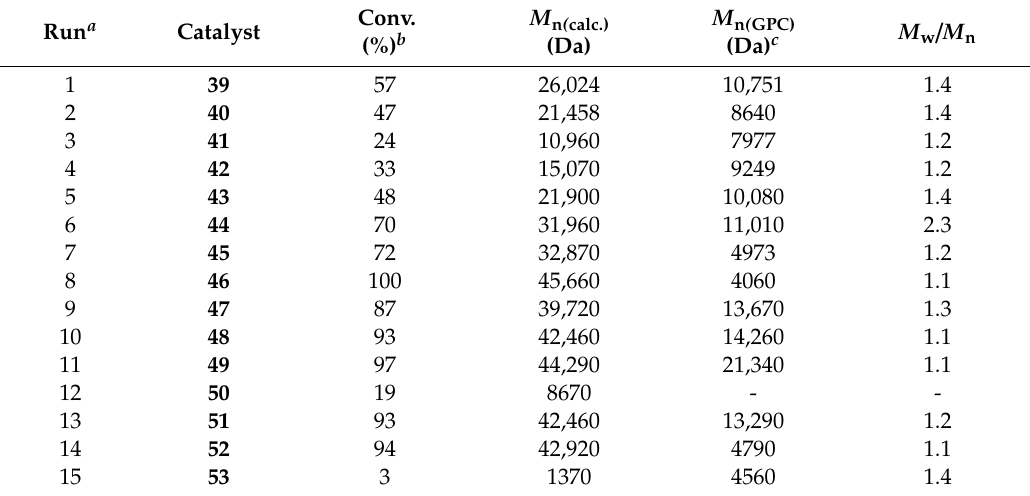
Table 5. ROP of ε -CL promoted by 39–53 [47].